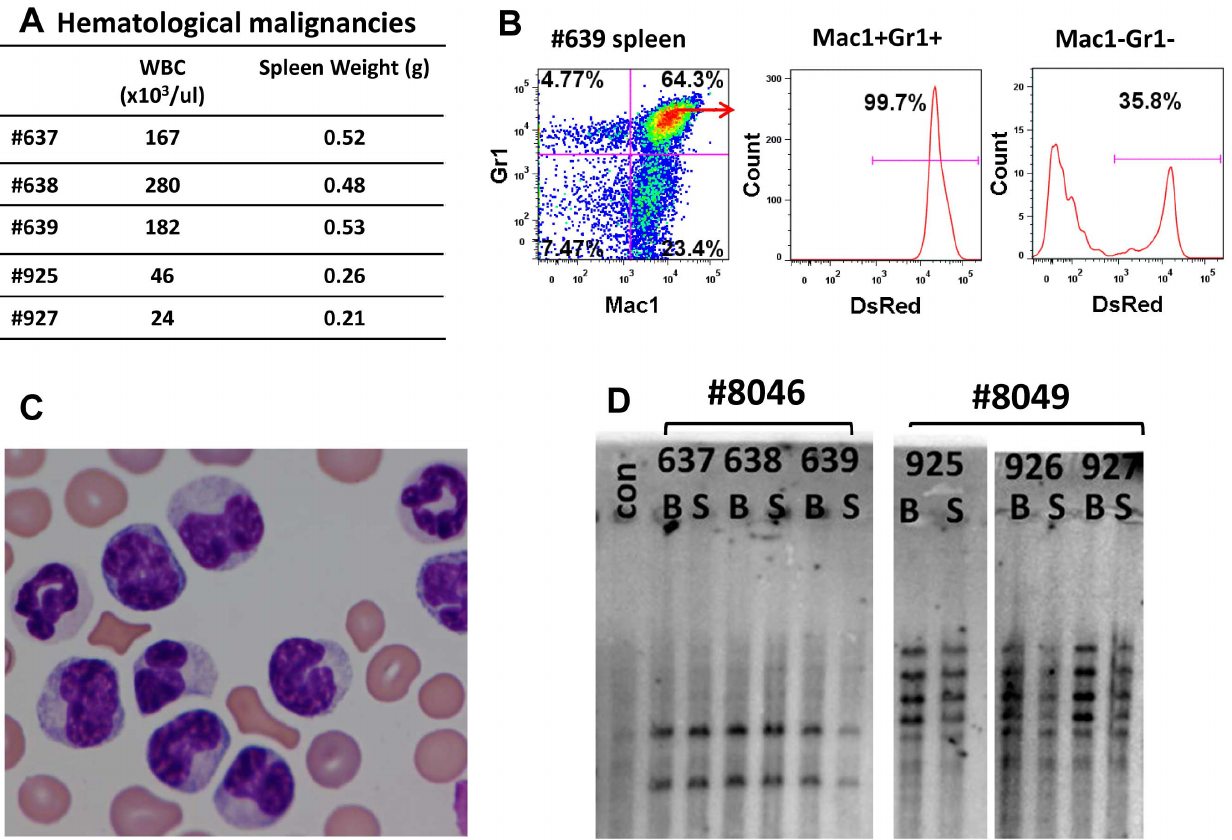
Figure 4. Characterization of myeloid malignancies seen in the SFFV-treated secondary recipients. (A) Hematologic characteristics of myeloid leukemias including peripheral leukocyte counts and spleen weights in individual mice at the time of euthanasia. (B)Flow cytometry analysis of splenic tumor cells from mouse # 639. Staining for the Gr1 and Mac1 myeloid markers is shown. Gated normal cells (Gr1 2 Mac1 2 ) and tumor cells (Gr1 + Mac1 + ) were also analyzed for expression of the DsRed, vector-encoded marker. (C) Peripheral blood smear from a leukemic mouse with abnormal monocytic and granulocytic cells. (D) Southern blot analysis of DNA from bone marrow (B) and spleen (S) of six secondary mice that were derived from two primary recipients is shown. A clonal analysis for vector insertion sites was performed using a single cutter enzyme (BglII) and probed with DsRed cDNA probe. A common clonal pattern was noted from tumors derived from each primary recipient. All mice but # 926 had clinical evidence of leukemia, however it was noted that # 926 had already converted to a clonal